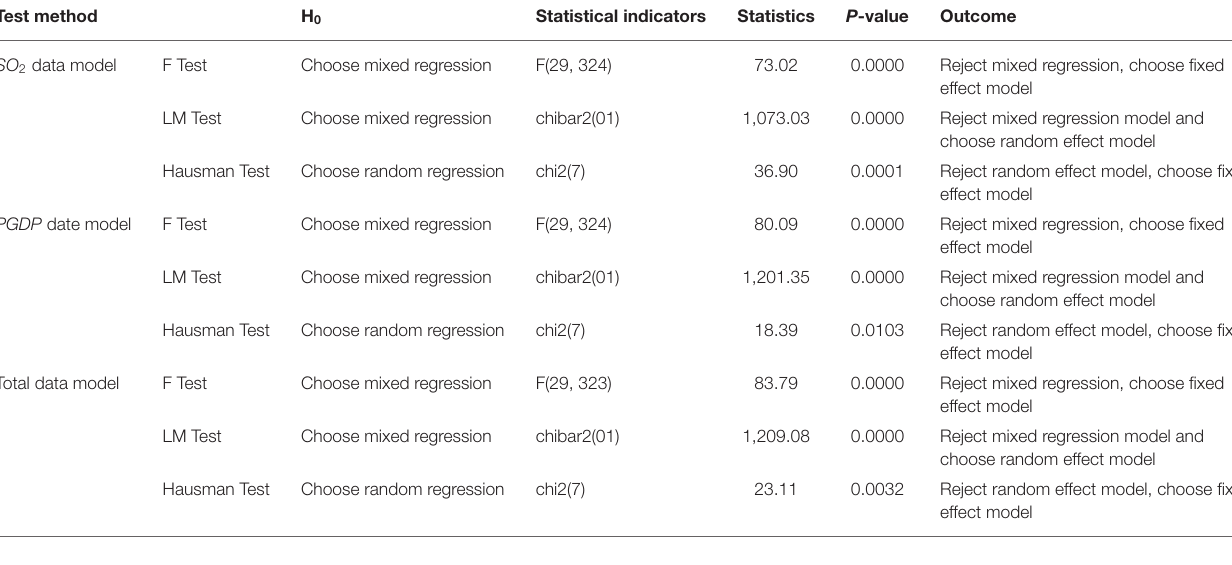
TABLE 5 | Results of national empirical analysis